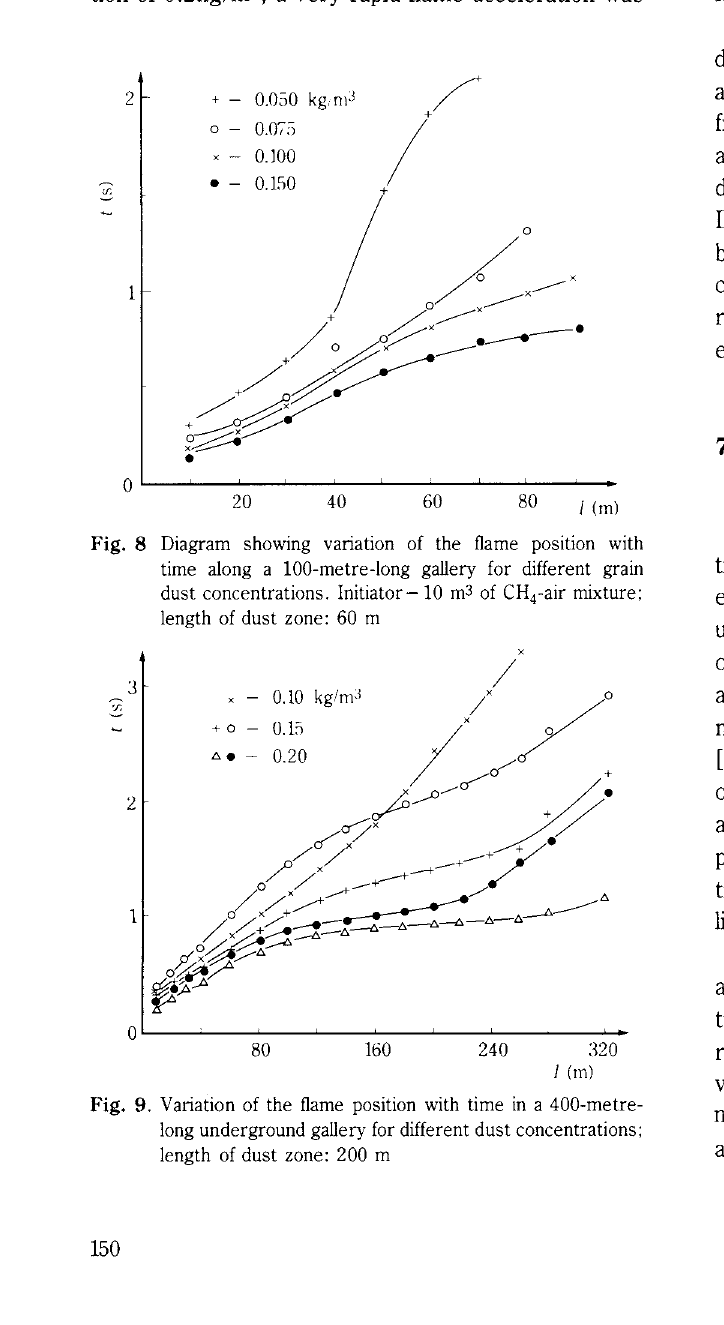
Fig. 9. Variation of the flame position with time in a 400-metre long underground gallery for different dust concentrations; length of dust zone: 200